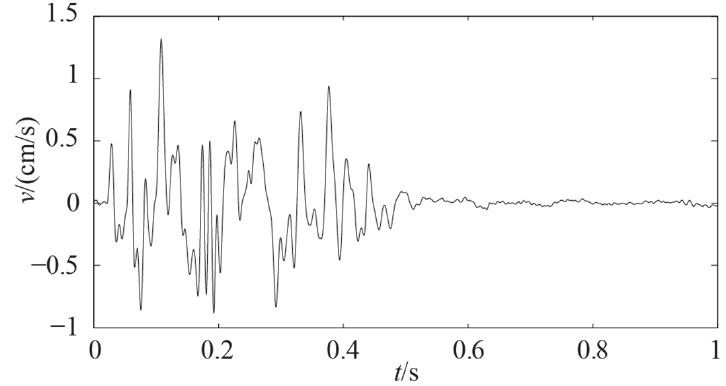
Figure 4. Blasting vibration signal after denoised.